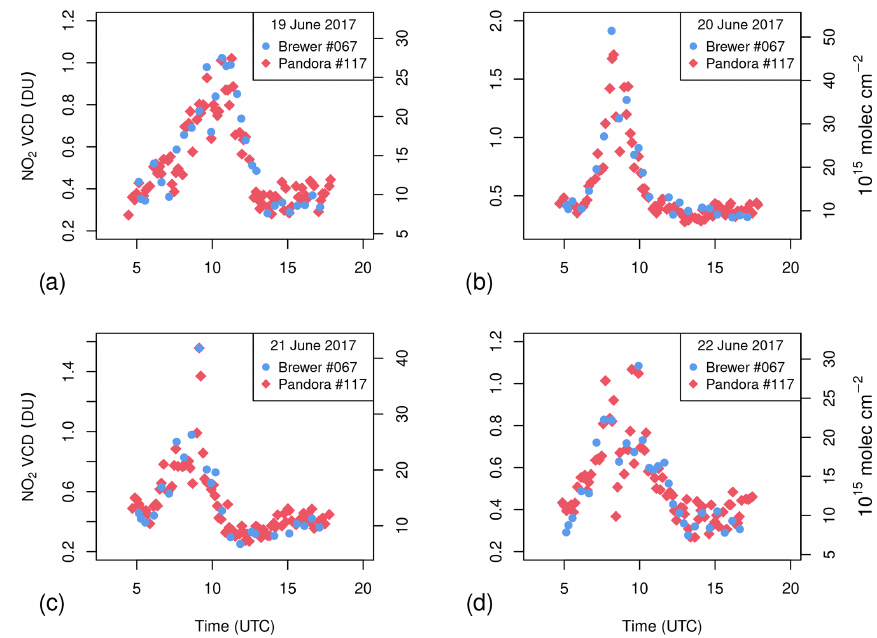
Figure 10. Independent retrievals from instantaneous measurements by Brewer #067 and Pandora #117 on four selected days (19– 22 June 2017). Notice that the range of the vertical axis on 20 and 21 June is different from the other two days and that in panel (c) the Brewer and Pandora measurements corresponding to the daily maximum (just before 10:00UTC) perfectly overlap at about 1.5DU and are not easily